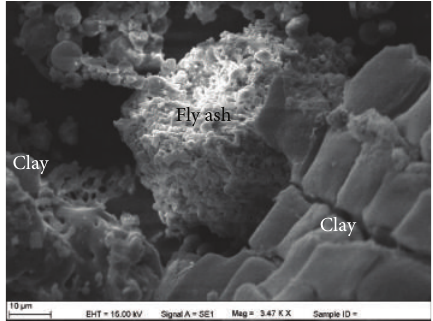
Figure 17: The view of ash particles that build the bridge between clay